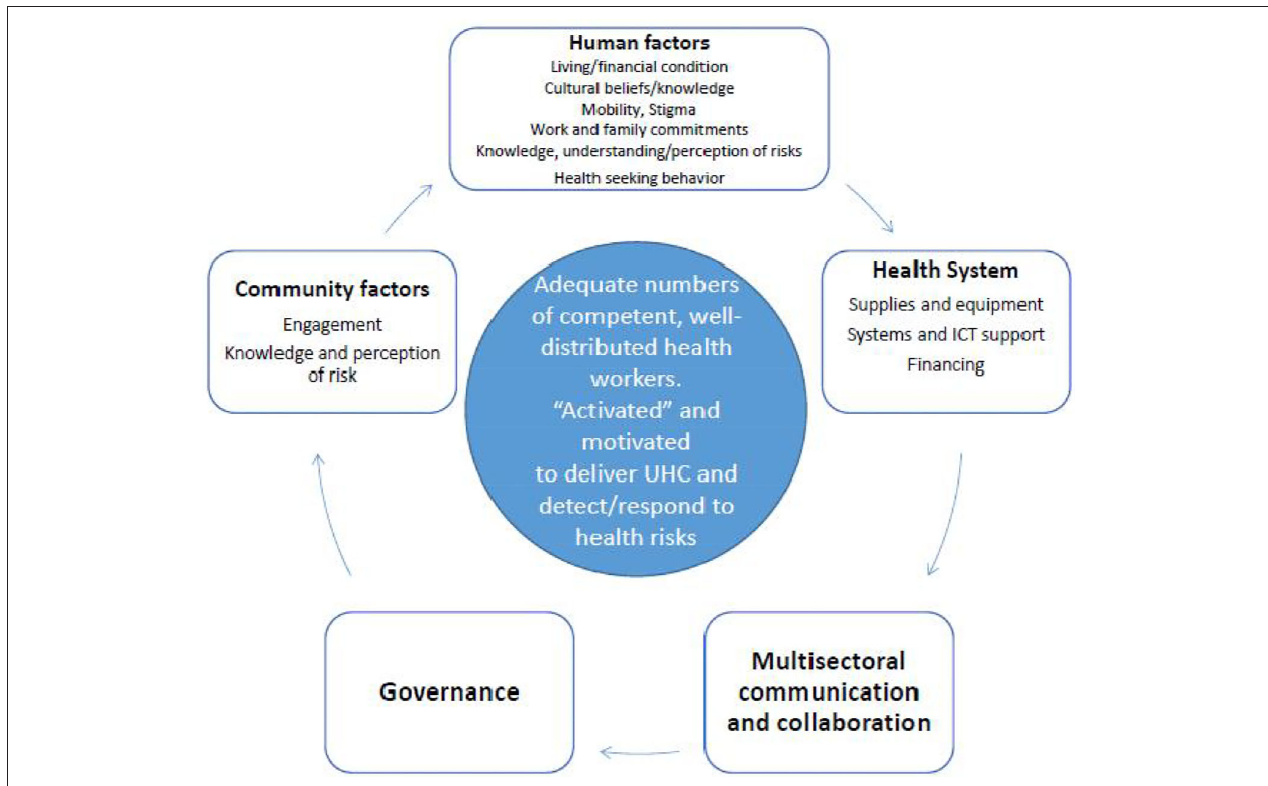
FIGURE 3 | Interconnections for a stronger rural health workforce and better health security.